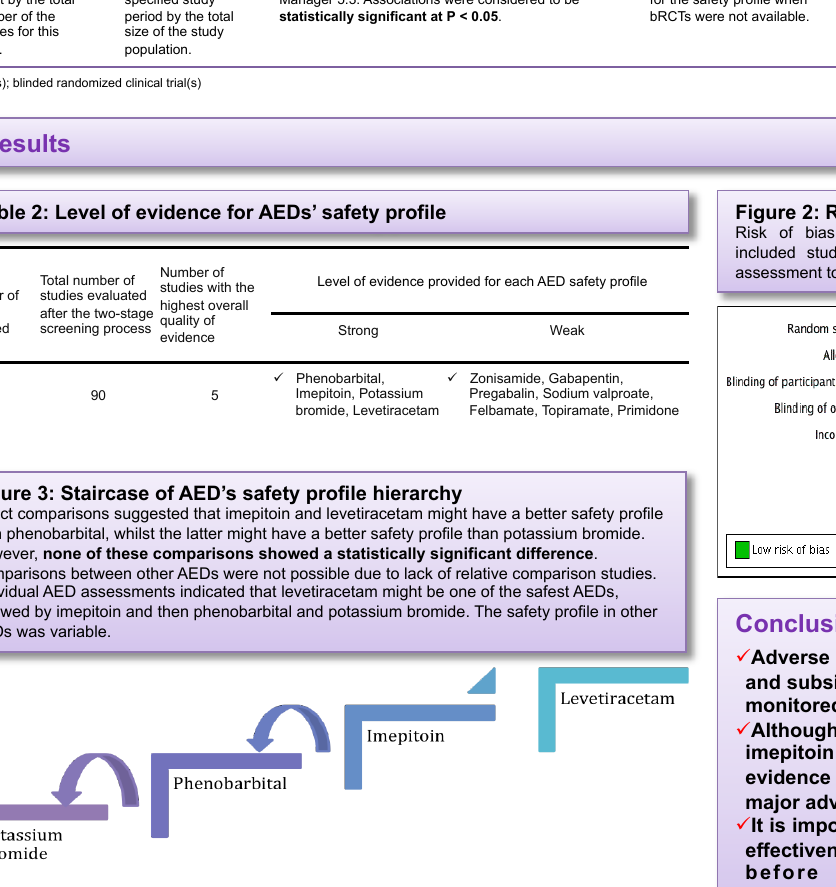
Table 2: Level of evidence for AEDs’ safety profile